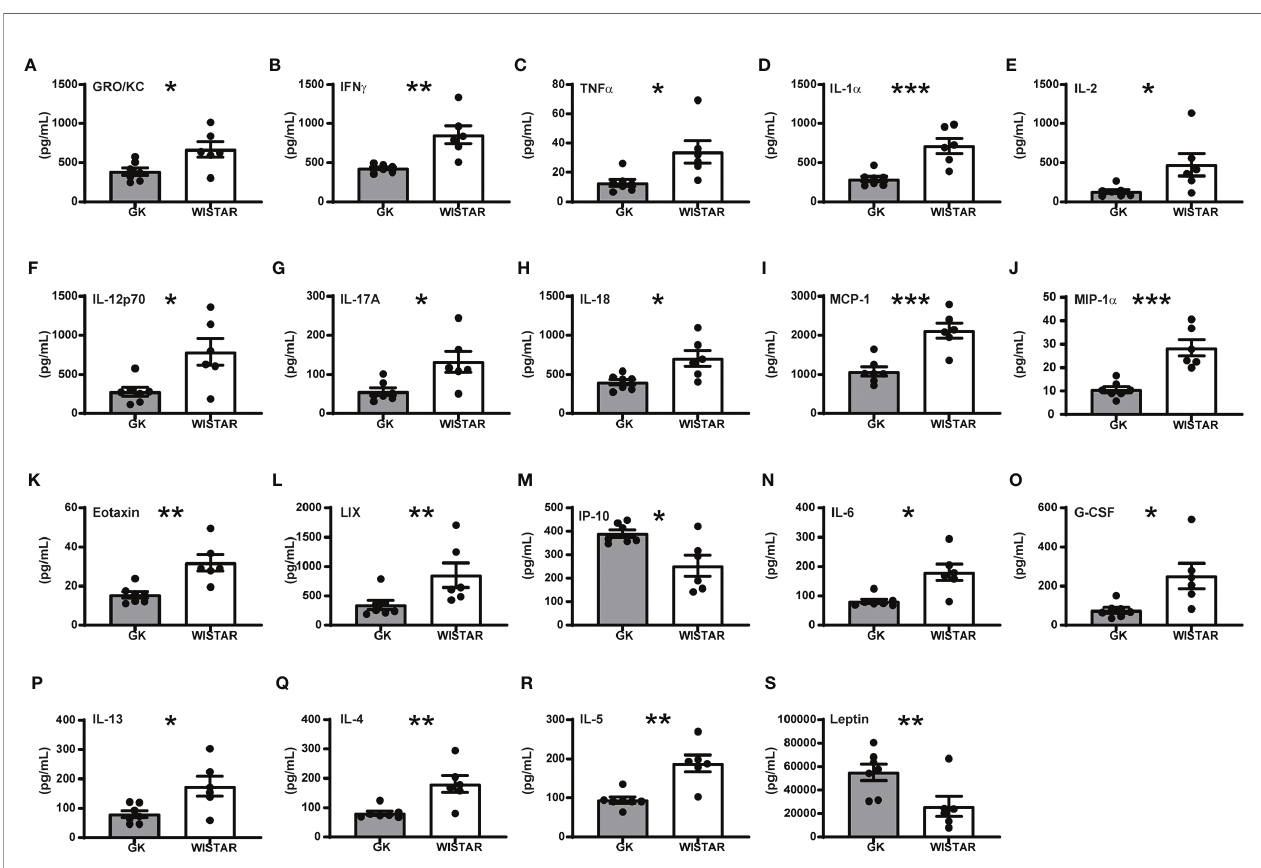
FIGURE 2 | Overall cytokine pro fi le shows limited peripheral in fl ammation in GK rats. All panels display the mean levels of plasma cytokines (mean +/- SEM) in pg/ mL, that were signi fi cantly different (p<0.05) in the GK rats compared to the controls. Cytokines shown in panels (A – M) are proin fl ammatory, (N) is both pro- and anti-in fl ammatory, (O – Q) are anti-in fl ammatory while (R, S) show no in fl ammatory role. Grey bars: GK rats (n = 7); white bars: Wistar rats (n = 6). p < 0.001, p < 0.01 and p < 0.05 are re fl ected by ***, ** and * respectively. Student ’ s t-test was used except for panels E (IL-2), L (LIX), and R (IL5), which were analysed using a Mann- Whitney